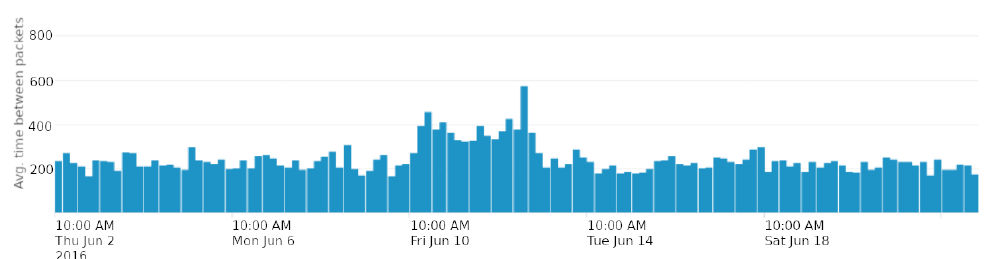
Figure 7. Average time between consecutive packets in the RPI network. These data have been aggregated every 4